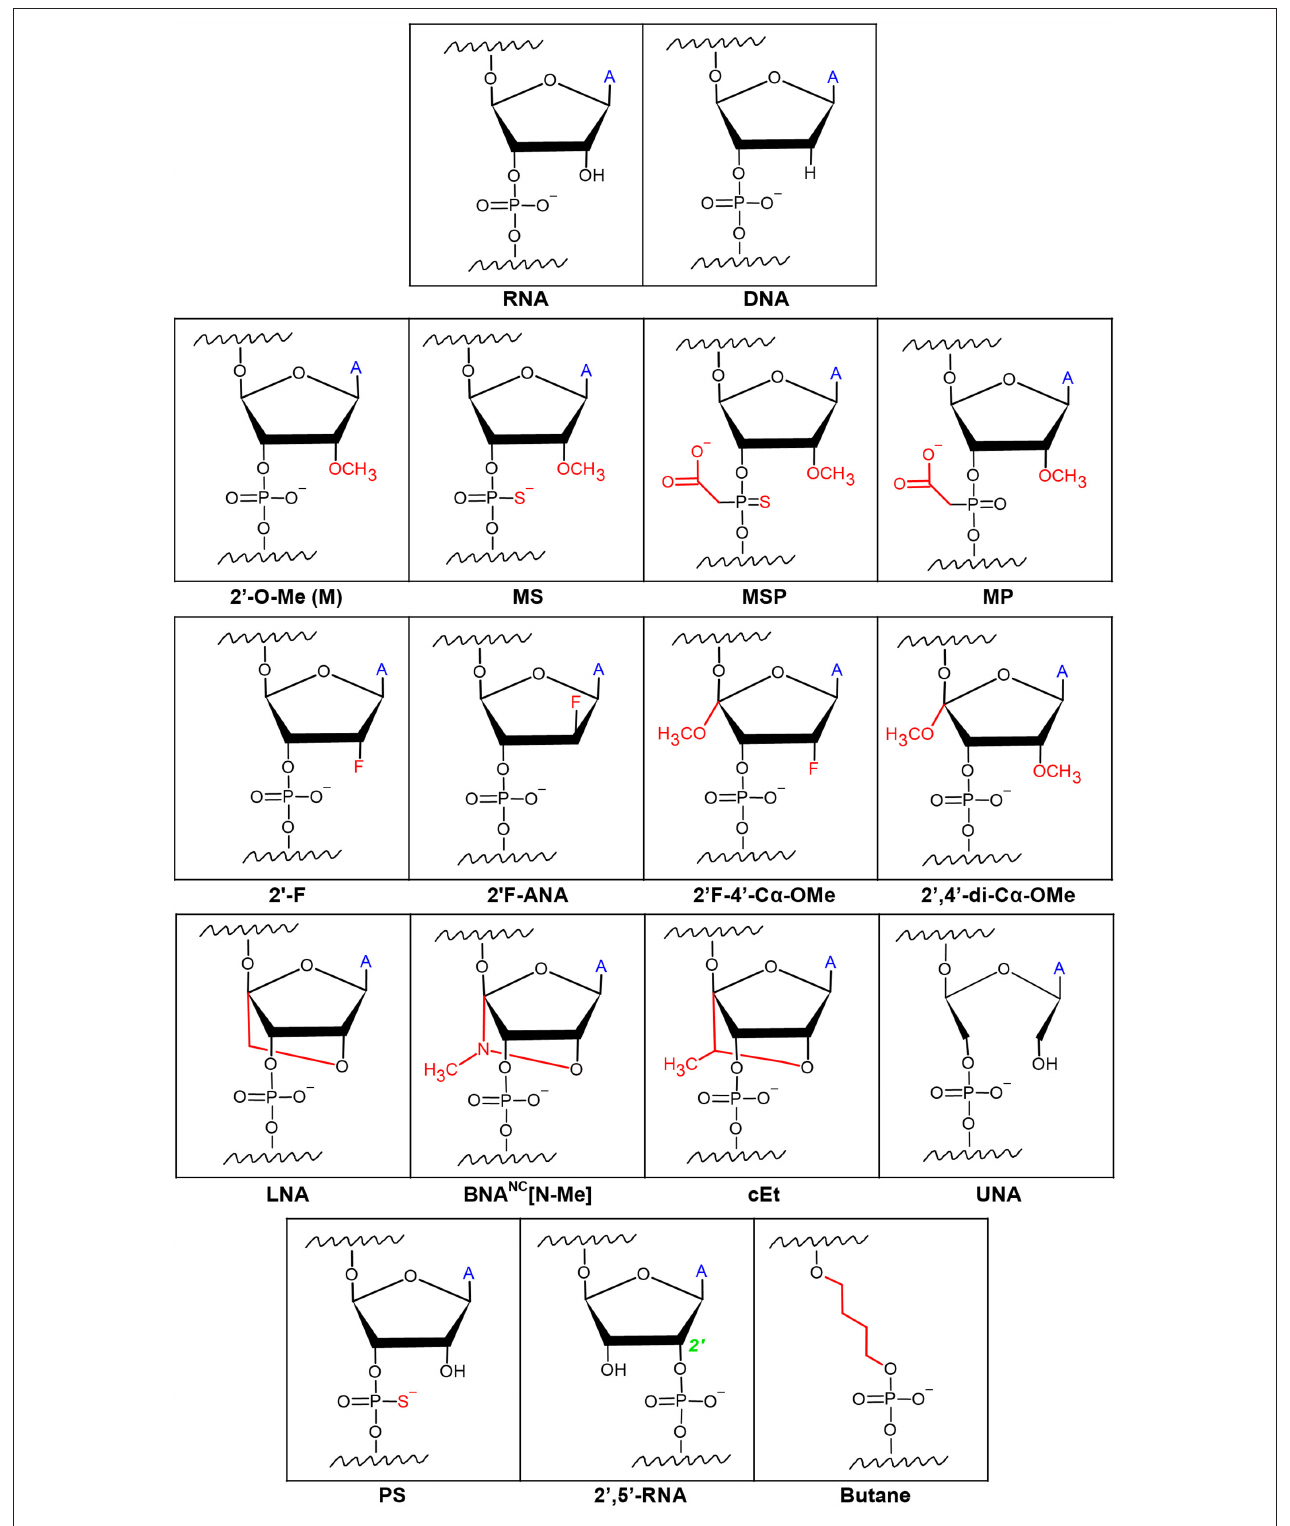
FIGURE 2 | Chemical modifications on the ribose rings and phosphate backbone of gRNAs. Ribose modifications are typically placed at the 2 ′ OH as it is readily available for manipulation. Simple modifications at the 2 ′ OH include 2 ′ -O-Me, 2 ′ -F, and 2 ′ F-ANA. More extensive ribose modifications such as 2 ′ F-4 ′ -C α -OMe